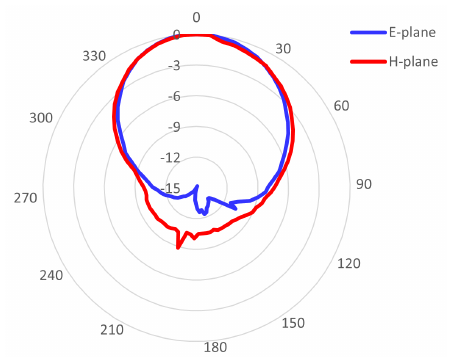
Figure 5. The measured radiation pattern of the resonant − frequency − corrected U.FL-based